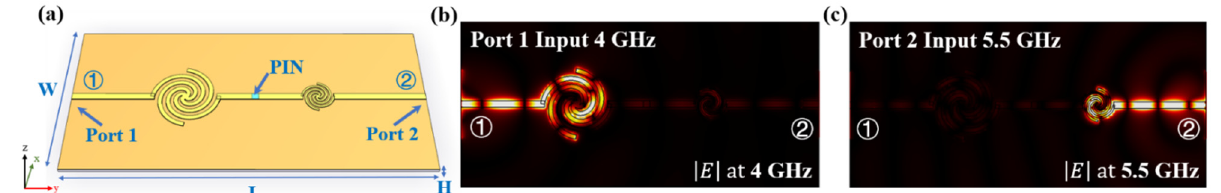
Figure 4. Microstrip with spiral SPP resonators in the static case: ( a ) Schematic of a microstrip composed of two different spiral SPP resonators; ( b ) Electric field distribution at 4 GHz when the PIN diode keeps the switched-on status; ( c ) Electric field distribution at 5.5 GHz when the PIN diode keeps the switched-on status.